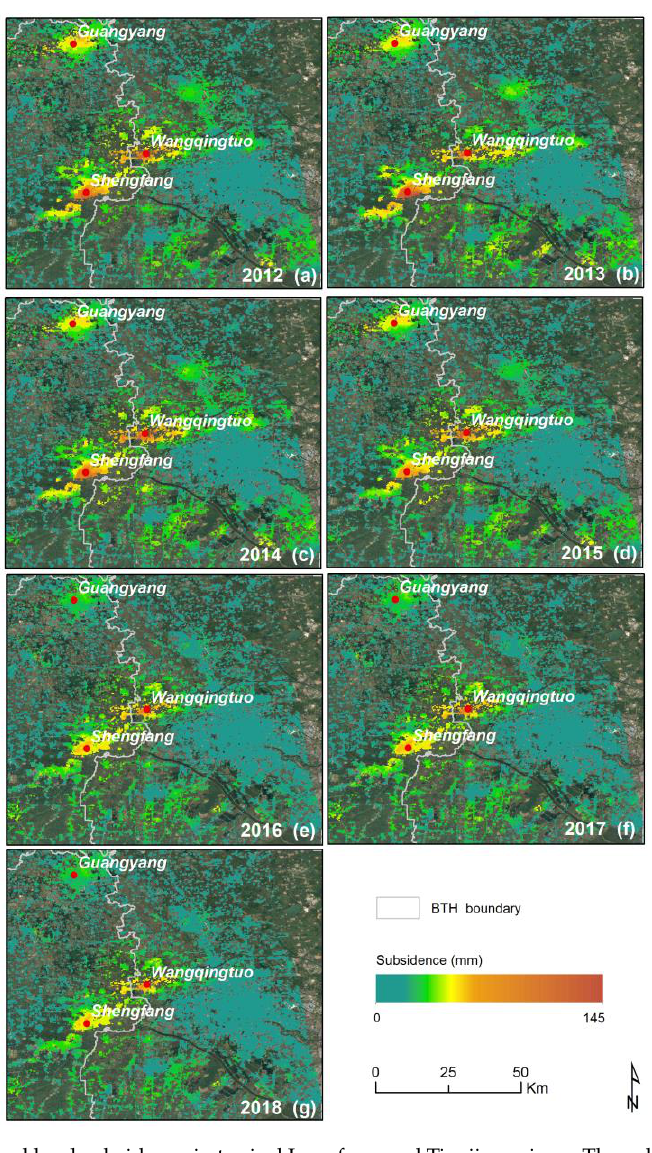
Figure 6. The annual land subsidence in typical Langfang and Tianjin regions. The subsidence observed in ( a – d ) is based on results from the Radarsat-2 data, while ( e - g ) show the results from the Sentinel-1 data. The three red circles are the locations of the subsidence features.